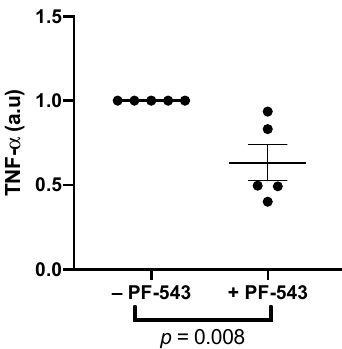
Figure 7. Inhibition of SphK1 decreased release of TNF- α . Explants were pre-cultured for 4 days prior to treatment with 1 µ M PF-543 or a no-treatment control for 48 h. Supernatants were centrifuged at 15,000 RPM for 15 min prior to quantification of TNF- α using a multiplex array. Results were normalized against total protein mass, and normalized values were graphed as a ratio of change from the untreated control explant cultures. ( n = 5, Mean ± SEM, Mann–Whitney test).